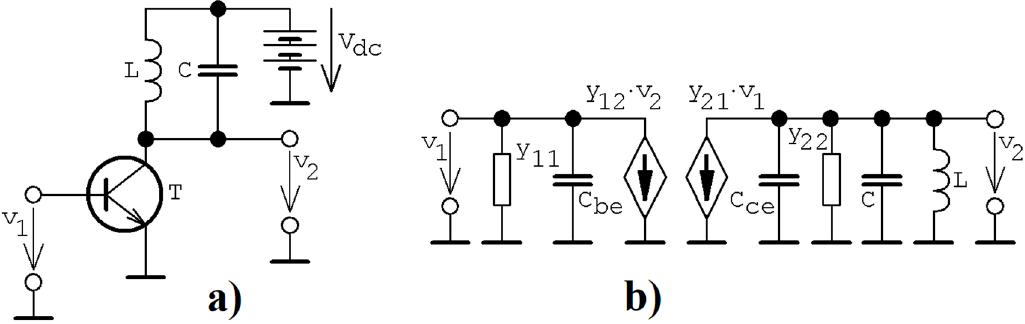
Figure 1. Bipolar transistor circuits: ( a ) principal concept and ( b ) equivalent circuit for high-frequency band.